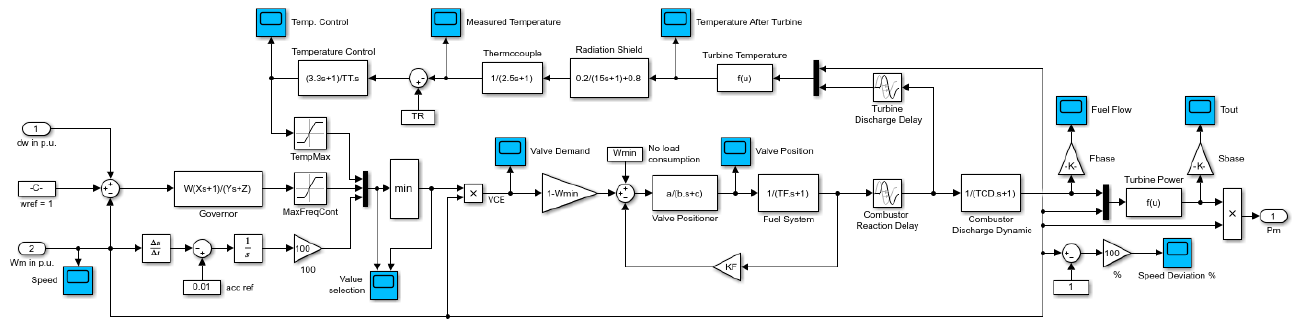
Figure 4. Simulation model of a single-shaft gas turbine built in MATLAB Simulink according to Rowen [51].